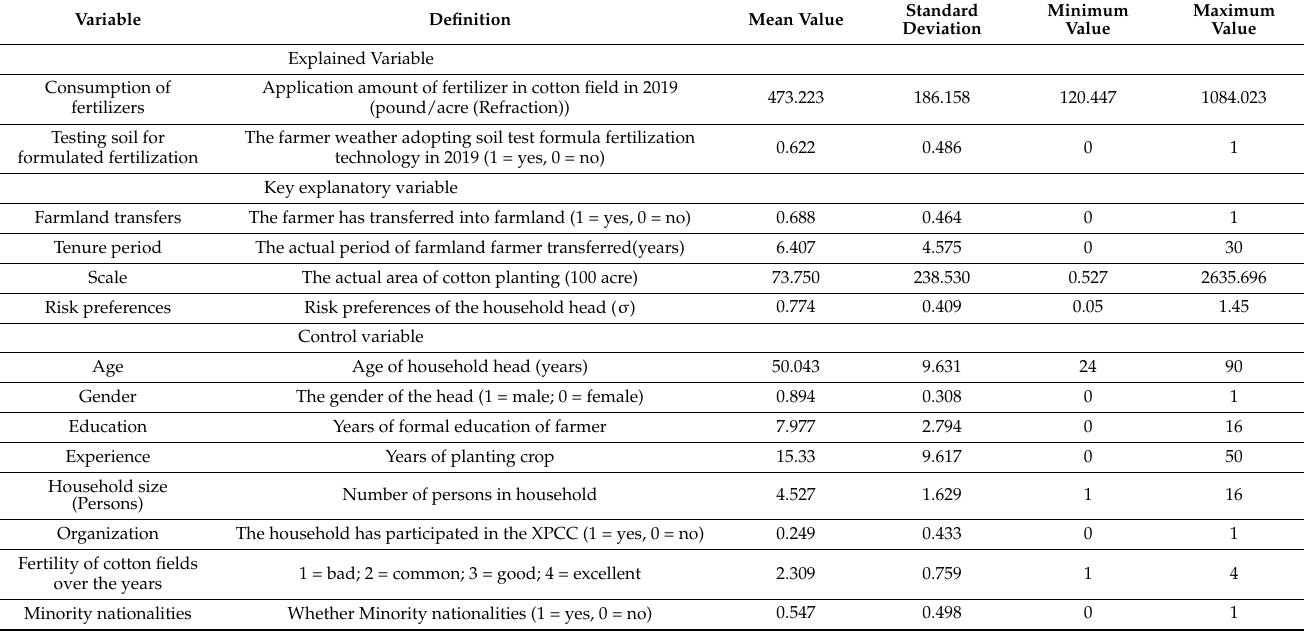
Table 1. Definition and value range of model